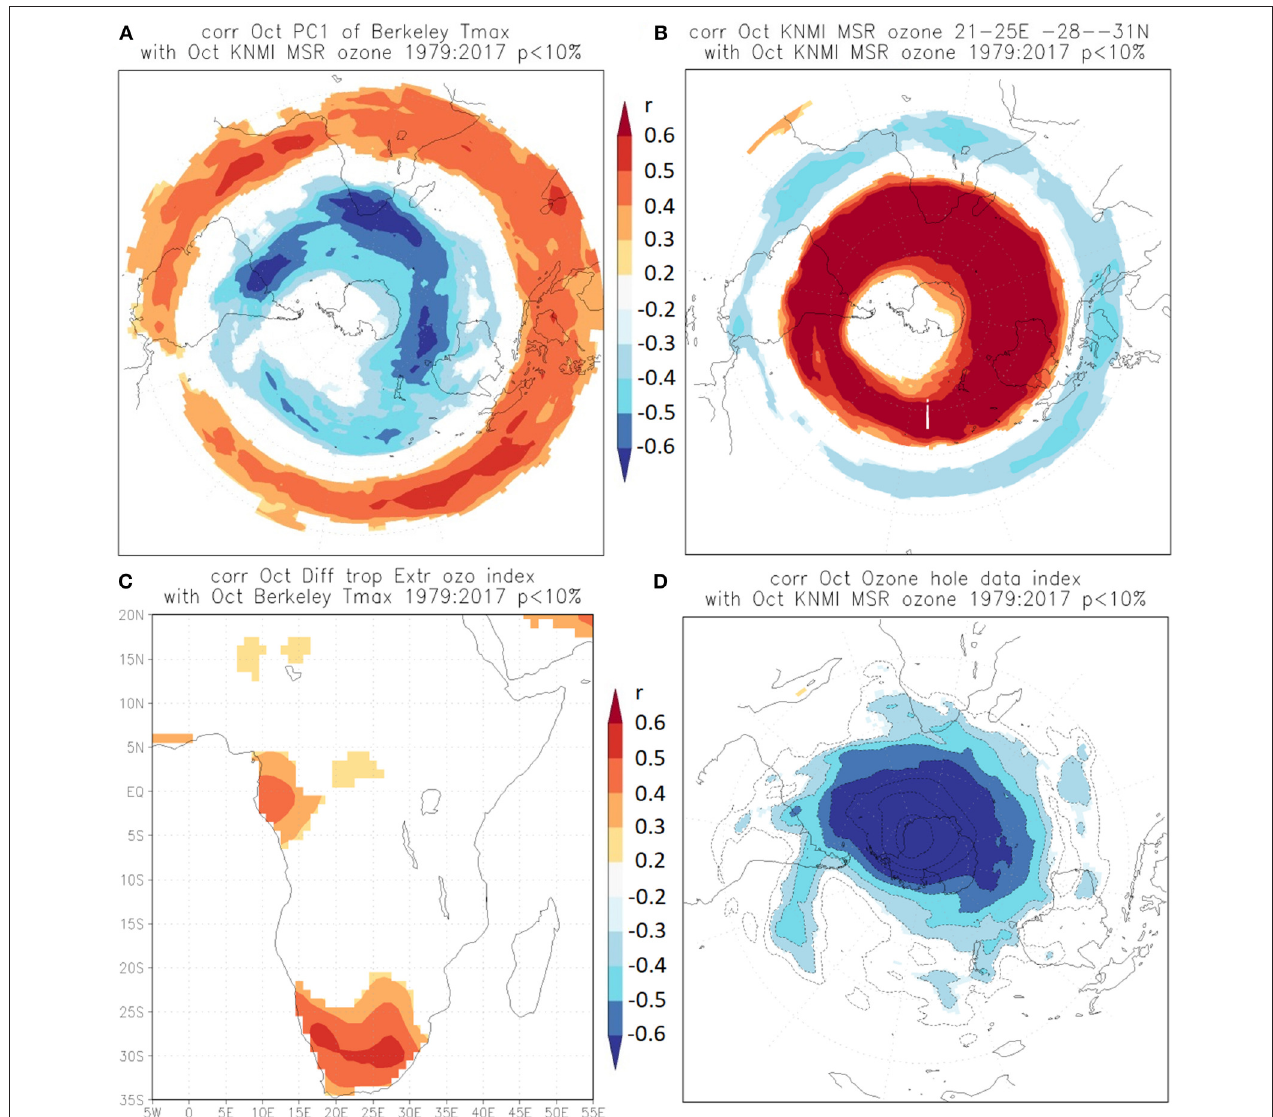
FIGURE 4 | Spatial manifestation of (A) correlation field between SAT_PC1 and the SATmax over the SH, and (B) SA_ozone and the ozone over the SH. (C) The spatial correlation between the tropics minus subtropics ozone averaged index and the SATmax over Africa. (D) correlation of ozone hole index with ozone over the SH. The data is from October from 1979 to 2017. Color shades depict regions of significance that is above the 90% confidence level using a 2 tailed t